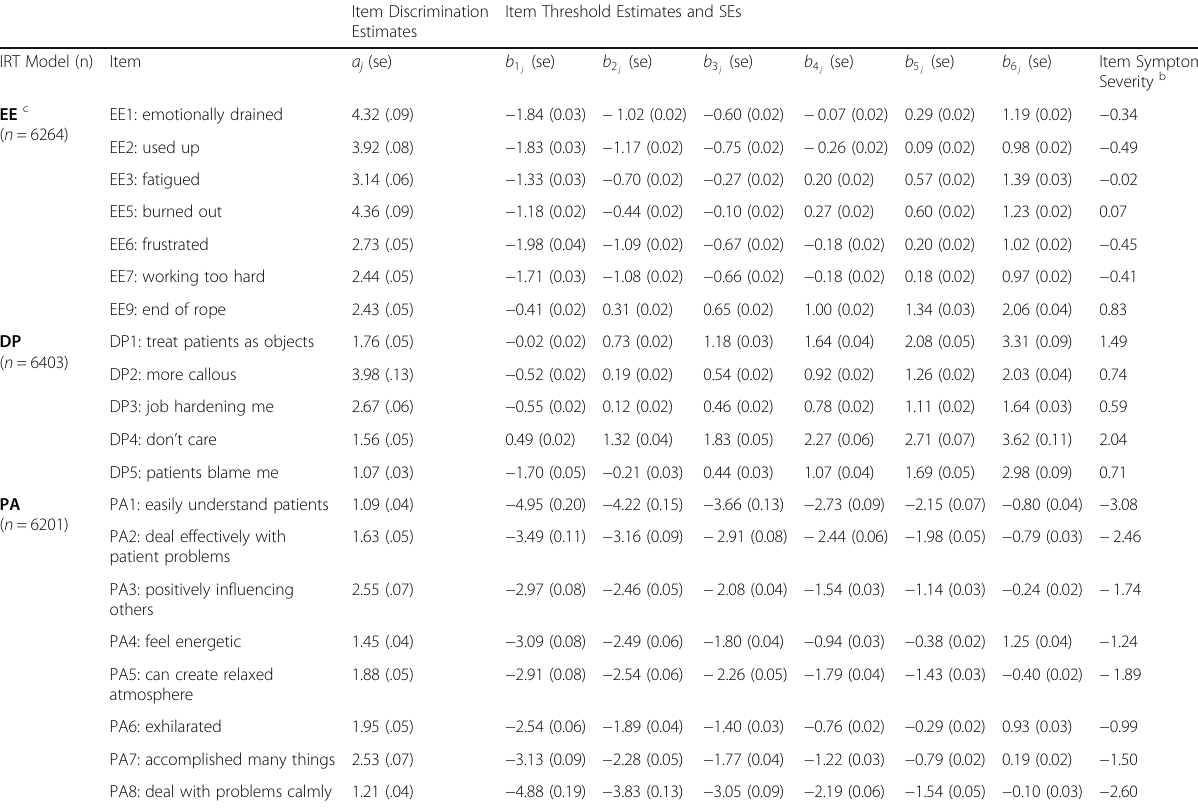
Table 2 Item Parameter Estimates and Standard Errors (SE) for Calibrated Emotional Exhaustion (EE), Depersonalization (DP), and Personal Accomplishment (PA) IRT Models a Item Discrimination Item Threshold Estimates and Estimates